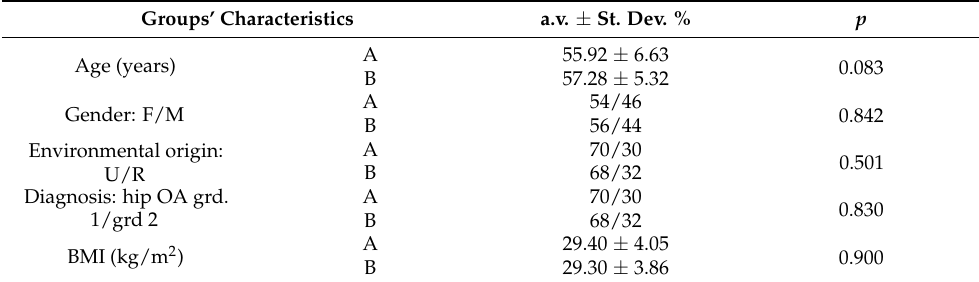
Table 1. Initial characteristics of the studied groups.